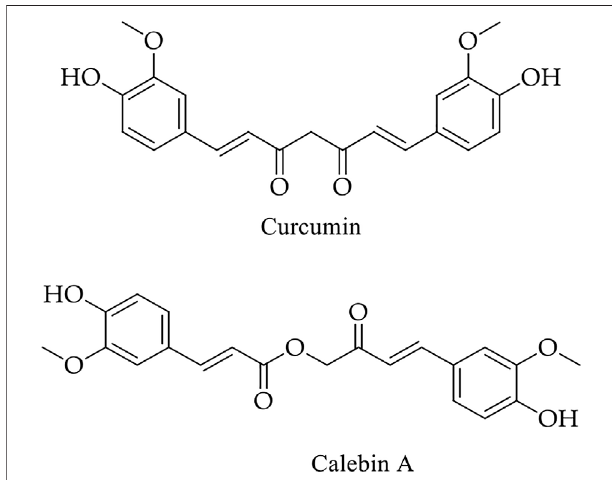
FIGURE 7 | Chemical structure of main bioactive compounds of